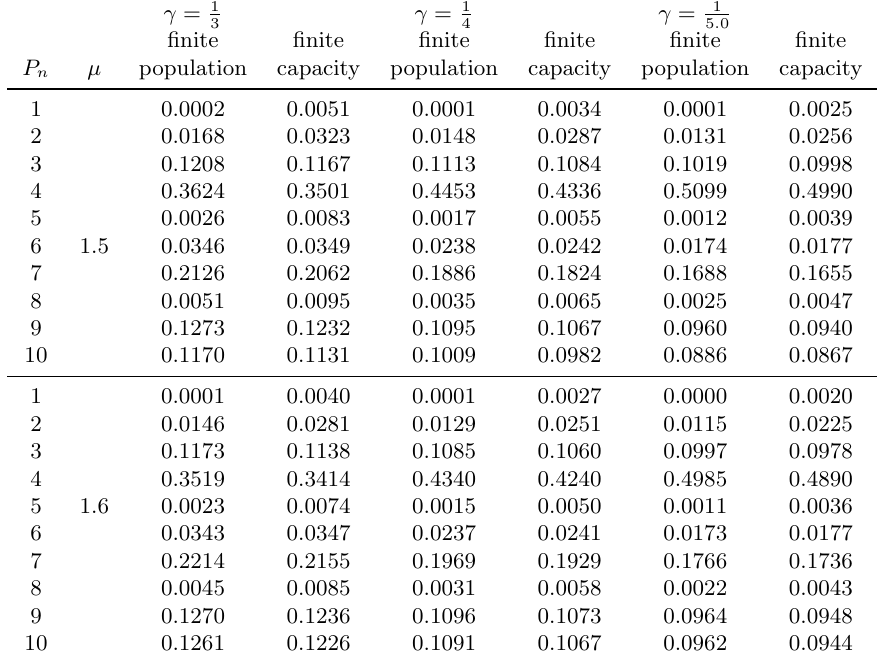
Table 1: Steady state probabilities for the finite population and finite capacity M/G/ 1 / 3 queueing